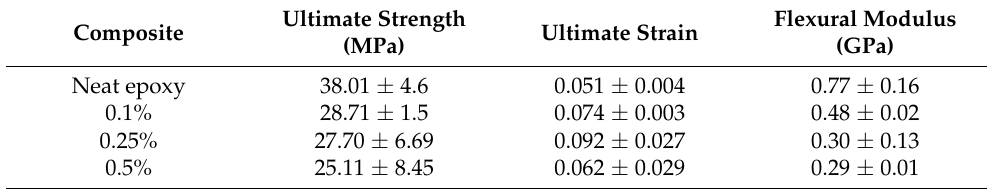
Table 5. Flexural properties of epoxy-ZnO composites after